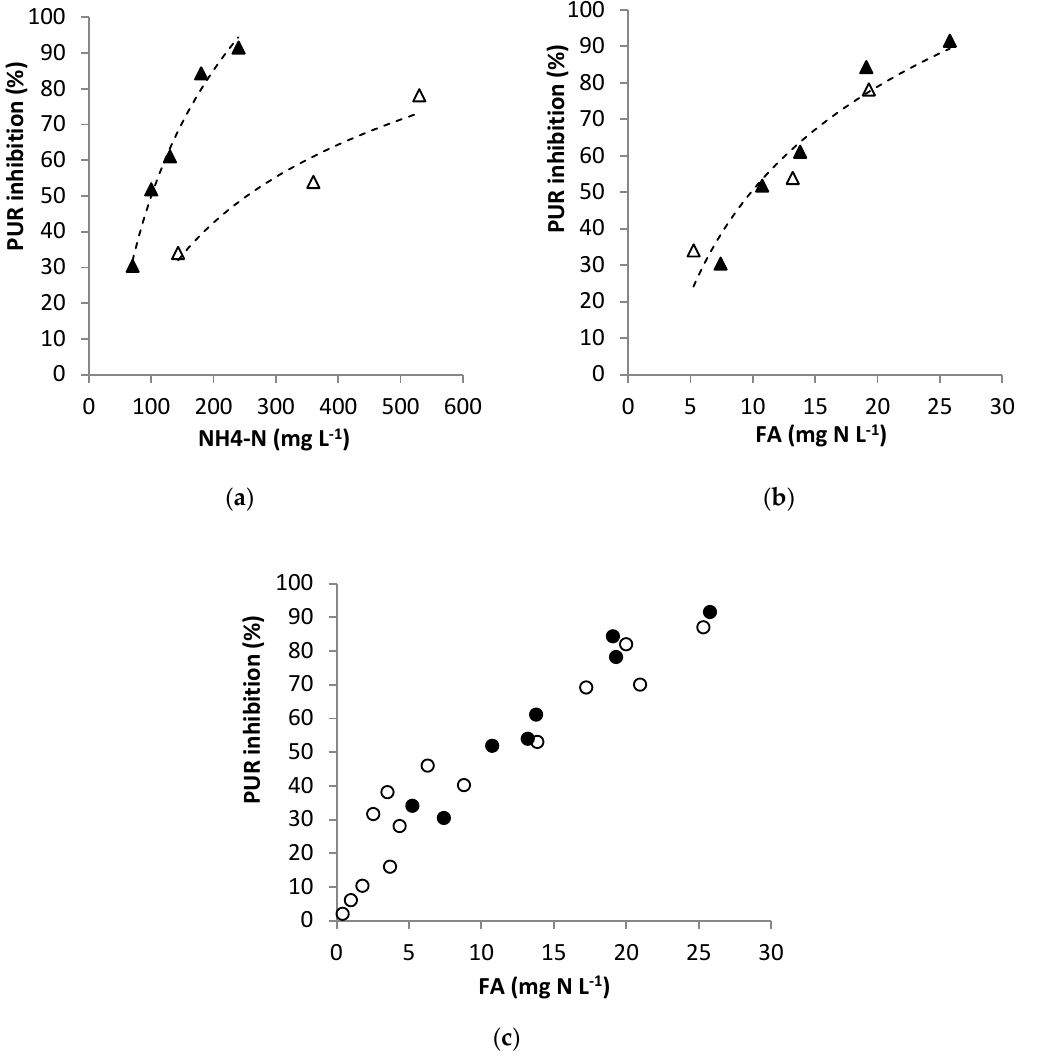
Figure 6. ( a ) The effect of ammonium on anoxic PUR for the pH of 8 ( ∆ ) and 8.5 ( ▲ ); ( b ) The effect of free ammonia (FA) on anoxic PUR for the pH of 8 ( ∆ ) and 8.5 ( ▲ ); ( c ) the comparison of anoxic PUR inhibition by FA ( ● ) with aerobic PUR inhibition by FA ( ○ ) [7].